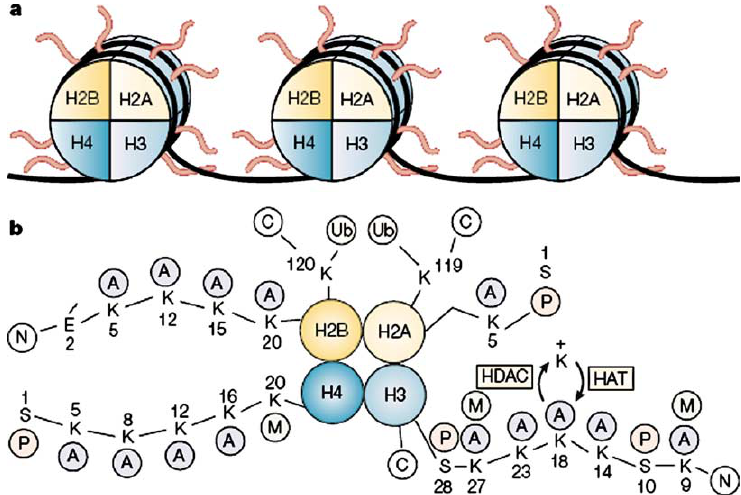
Fig. 1. Schematic structure of histones in nucleosomes. (a) The core proteins of nucleosomes are designated H2A (Histone 2A), H2B (Histone 2B), H3 (histone 3) and H4 (histone 4). Each histone is present in two copies, so the DNA (black) wraps around an octamer of histones called the core nucleosome. (b) The amino terminal tails of core histones, lysines (K) in the amino-terminal tails of histones H2A, H2B, H3 and H4 are potential acetylation/deacetylation sites for histone acetyltransferases (HATs) and histone deacetylases (HDACs). Acetylation neutralizes the charge on lysines. A, acetyl; C, carboxyl terminus; E, glutamic acid; M, methyl; N, amino terminus; P, phosphate; S, serine; Ub, ubiquitin. (Reproduced with permission from Nature Reviews Cancer (Nat. Rev. Cancer 1 (3) (2001), 194–202), copyright (2001) Macmillan Magazines